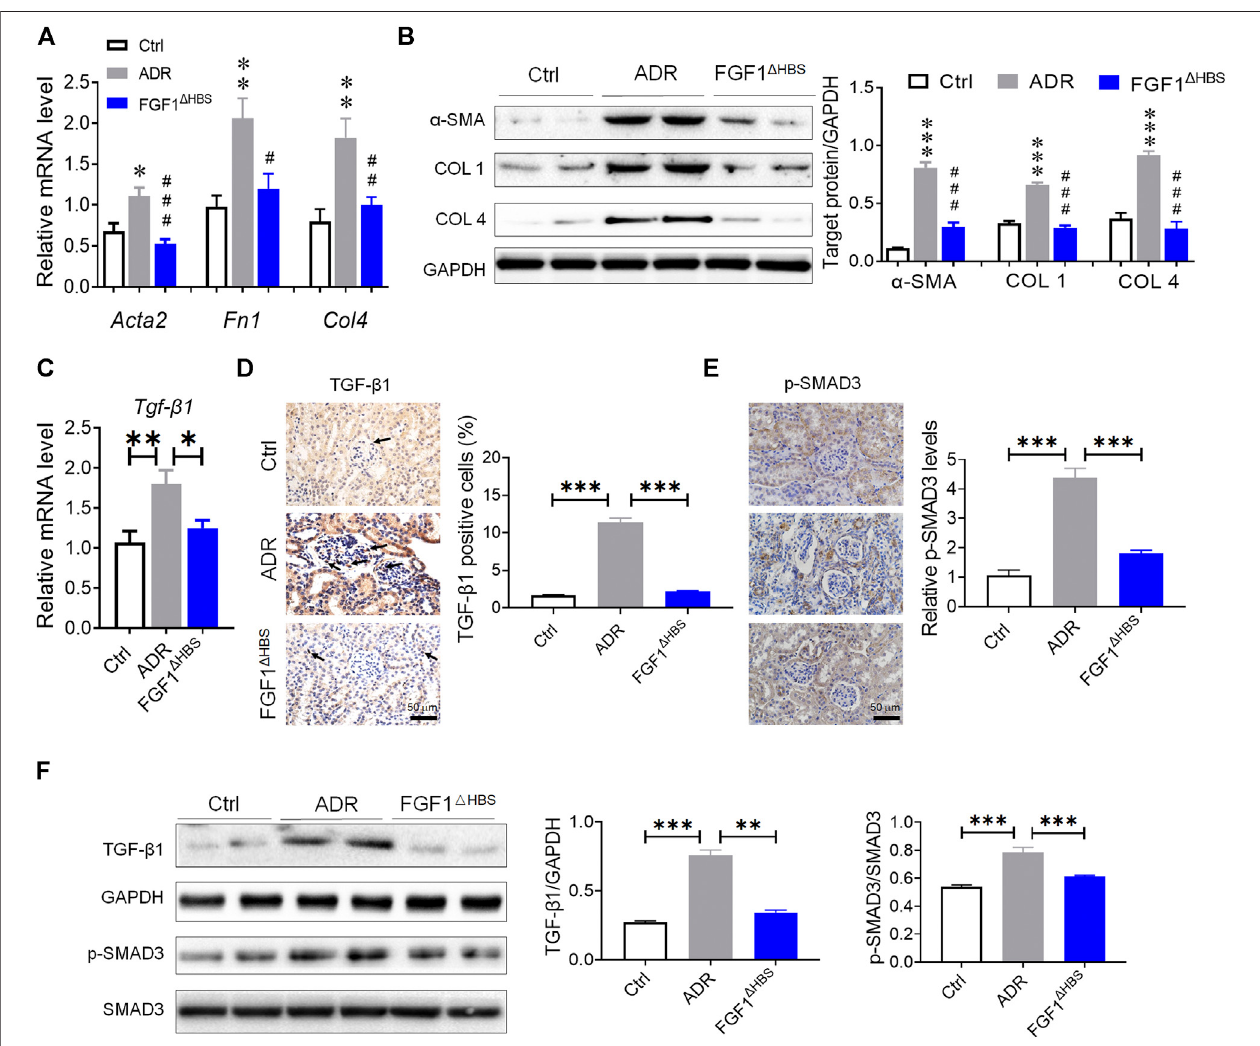
FIGURE 5 | FGF1 Δ HBS inhibited ADR-induced the upregulation of TGF- β 1 and phosphorylation of SMAD3. (A) Real-time PCR analysis of Acta2 , Fn1 , and Col 4 mRNAexpression. (B) Expressionlevelsof α -SMA,COL1,andCOL4asdeterminedbywesternblotanalysisandquantitationusingImageJ. (C) Real-timePCRanalysis of TGF- β 1 mRNA expression levels. (D) Representative images of TGF- β 1 immunohistochemical staining of renal tissues and quantitation using ImageJ. (E) Representative images of phosphorylated SMAD3 immunohistochemical staining of renal tissues and quantitation using ImageJ. ( F ) Expression levels of phosphorylated SMAD3, SMAD3, and TGF- β 1 as determined by western blot analysis and quantitation using ImageJ. Data are presented as the mean ± SEM ( n (cid:1) 6); Panels (A,B) , * p < 0.05, ** p < 0.01, *** p < 0.001 vs. d b/m ; # p < 0.05, ## p < 0.01, ### p < 0.001 vs. d b/ d b ; Panels (C – F) , * p < 0.05, ** p < 0.01, *** p <